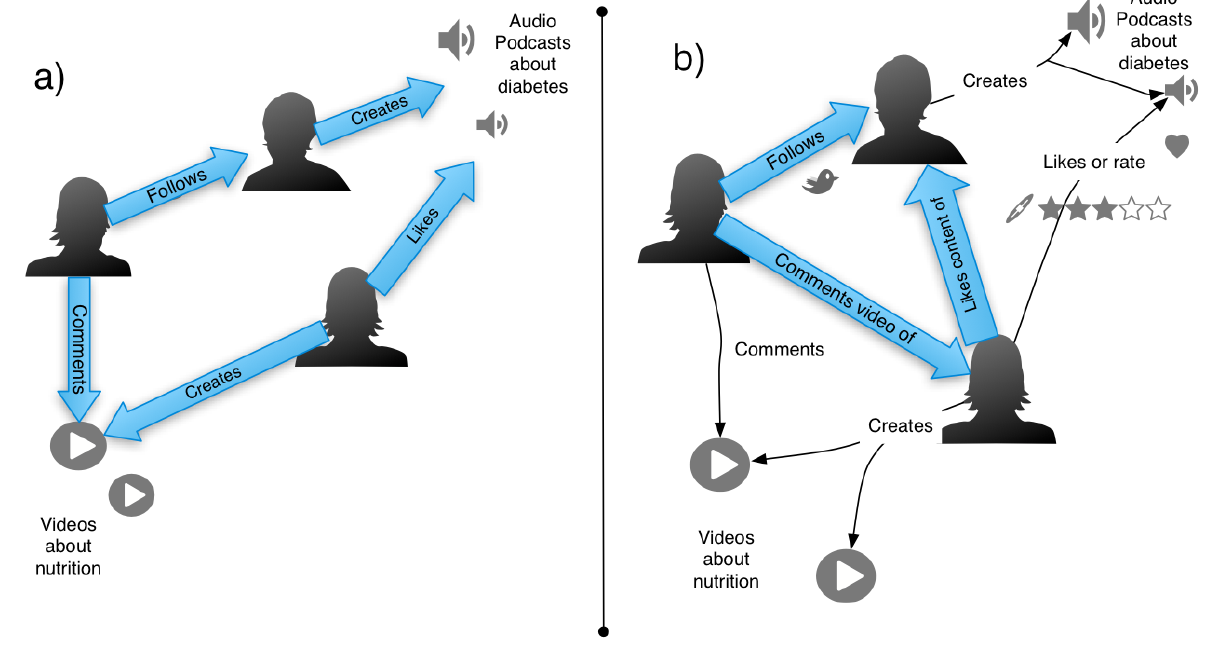
Figure 4. Links (in blue) used to calculate authoritativeness of users (left) and content (right). Diagram based on Figure